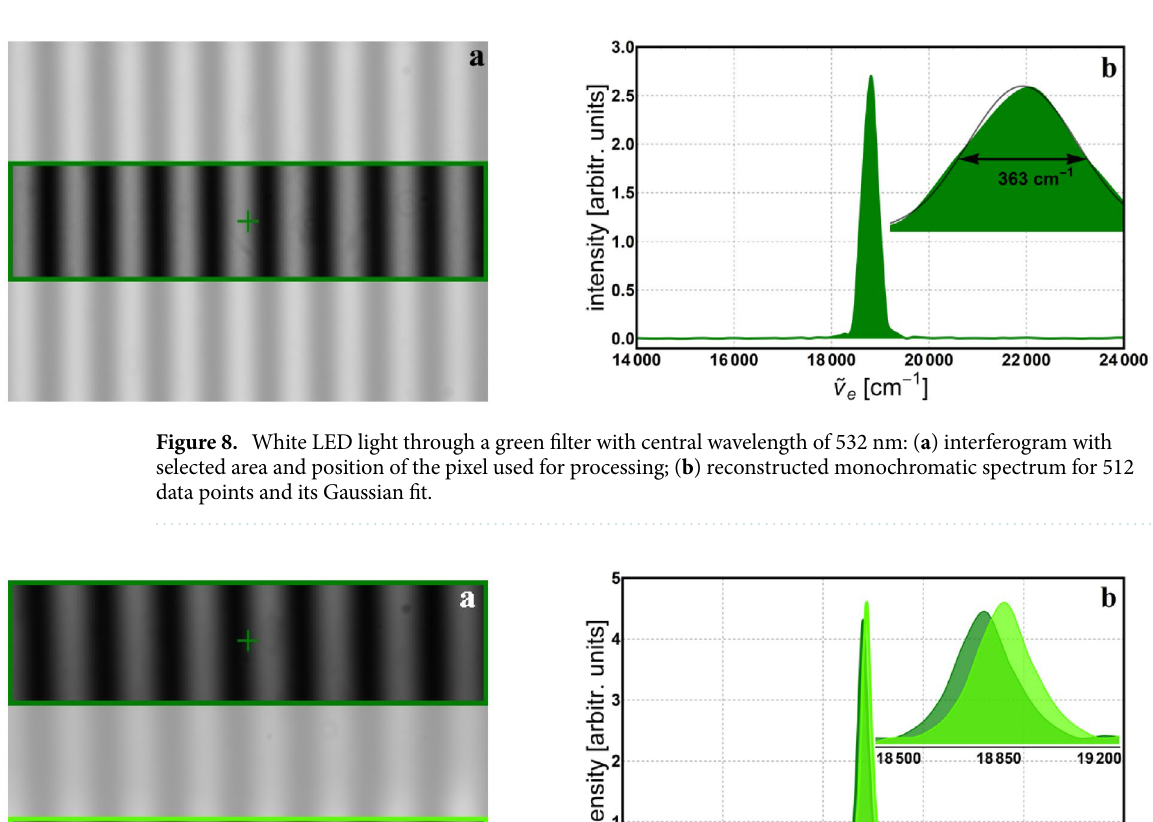
Figure 7. Composition of the individually measured spectra for: ( a ) ARCspectro HT-HR commercial spectrometer with the corresponding Gaussian fittings (gray line), ( b ) geometric phase method for 512 data points (orange line) and the Gaussian fittings of the commercial spectrometer (blue-indigo line).